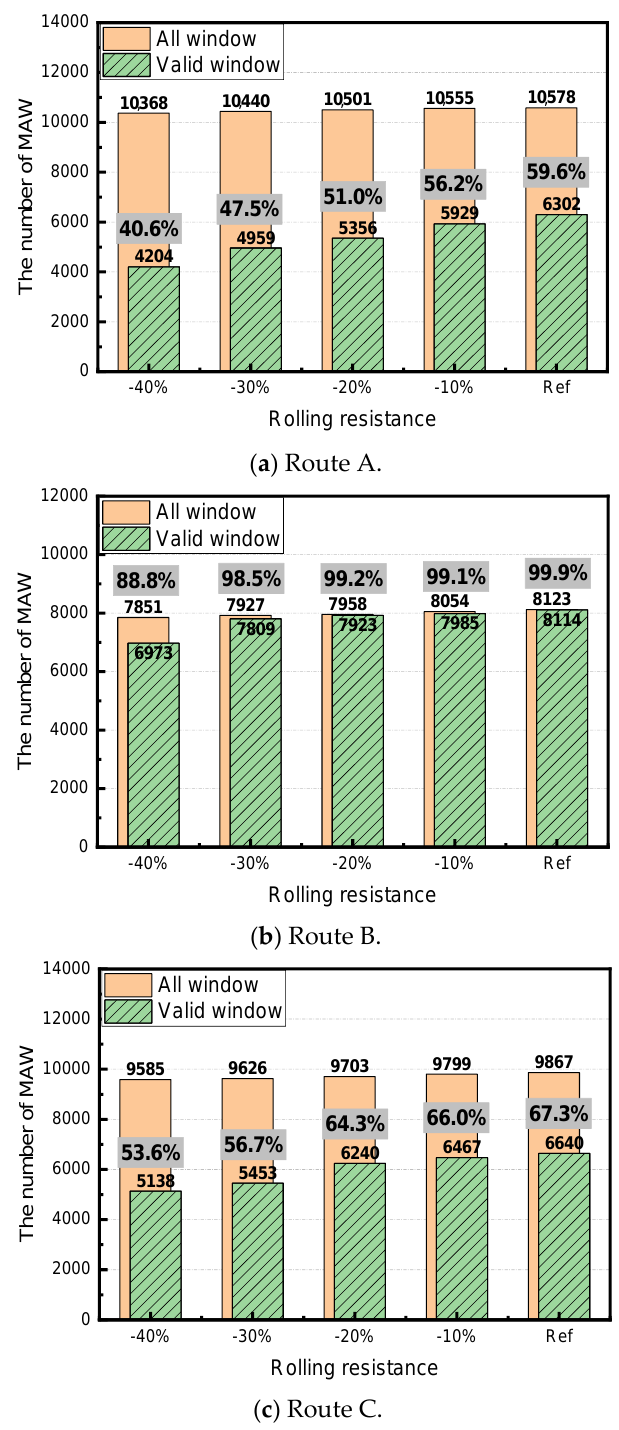
Figure 11. Number of MAWs and the ratio of the valid window with respect to the rolling resistance for each route.